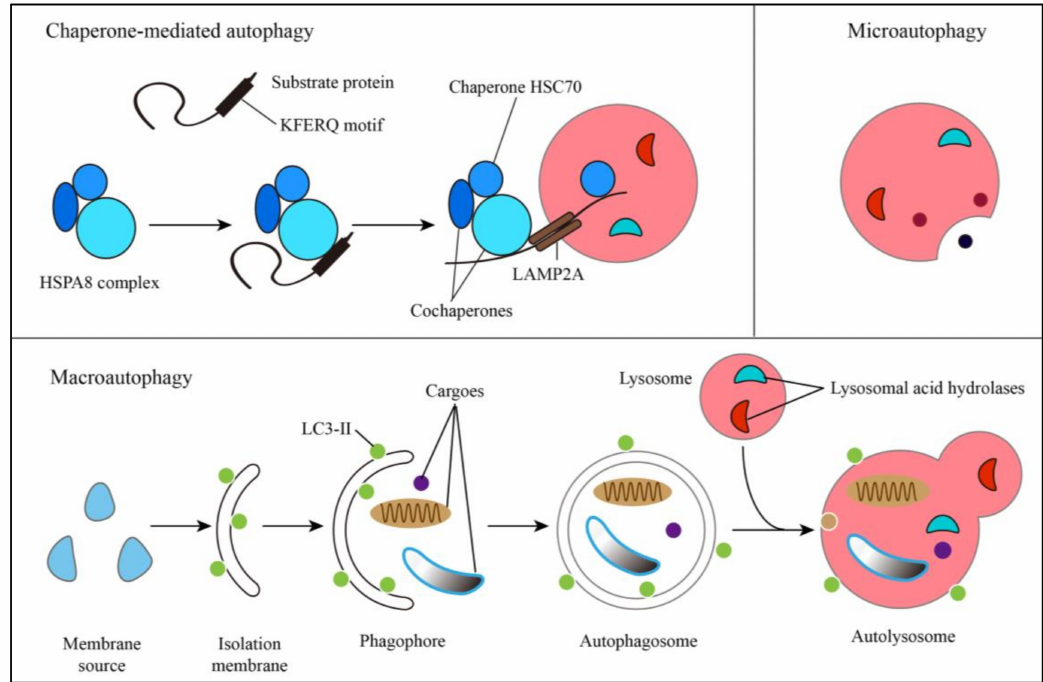
Figure 1. Three types of autophagy. In the major autophagic pathway, various organelles, including the endoplasmic reticulum (ER), mitochondria, mitochondria-associated membranes (MAMs), the Golgi, the plasma membrane and recycling endosomes could supply membrane sources for nucleation of the isolation membranes (originally termed the phagophore), which eventually develop into autophagosome through elongation. Mature autophagosome fuses with a lysosome to form an autolysosome, in which the cargoes sequestered by the autophagosome is degraded and released into the cytoplasm for use in cellular processes, including protein biosynthesis and energy